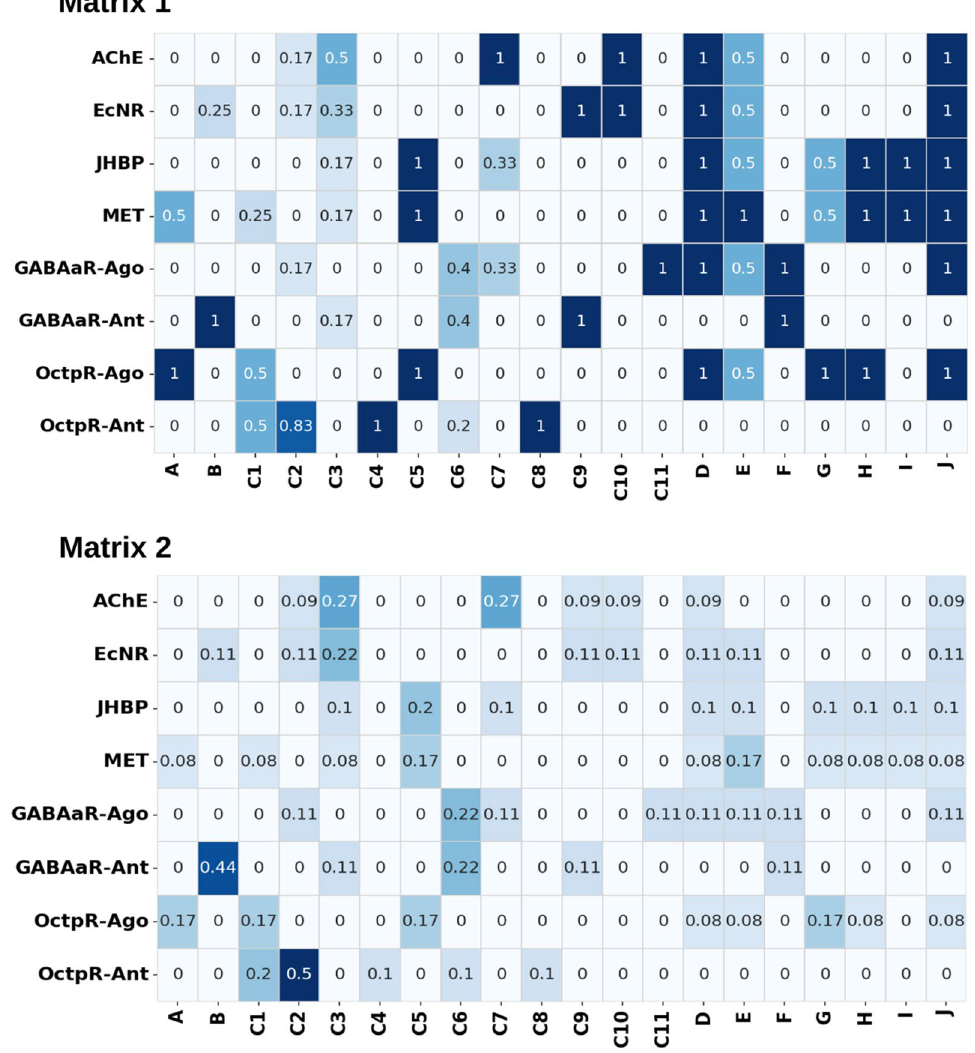
Figure 3. Matrix 1 shows the fraction of hits of ligands belonging to the cluster with high docking scores for the protein target; Matrix 2 otherwise presents the fraction of ligands that affect the protein target which belongs to each